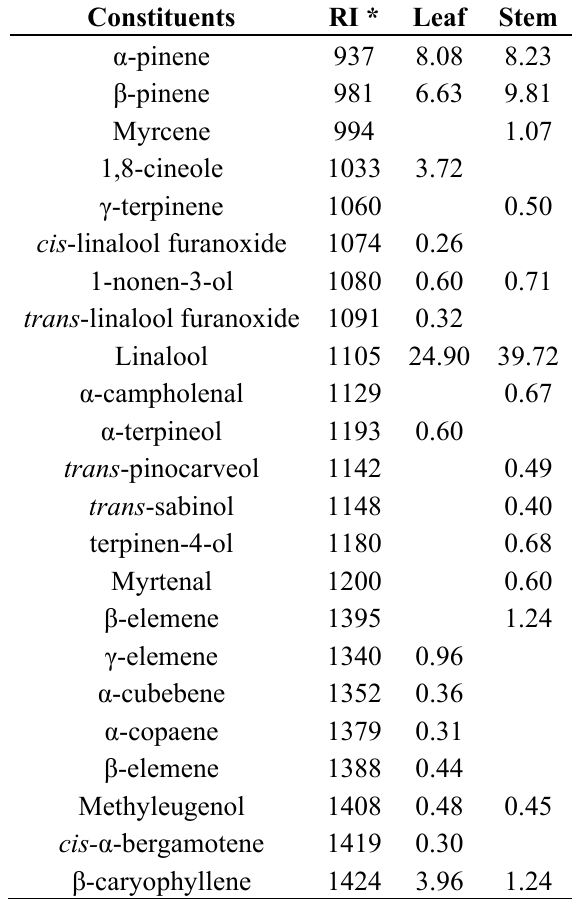
Table 1. Volatiles (%) identified in the leaf and stem oils of Croton pullei